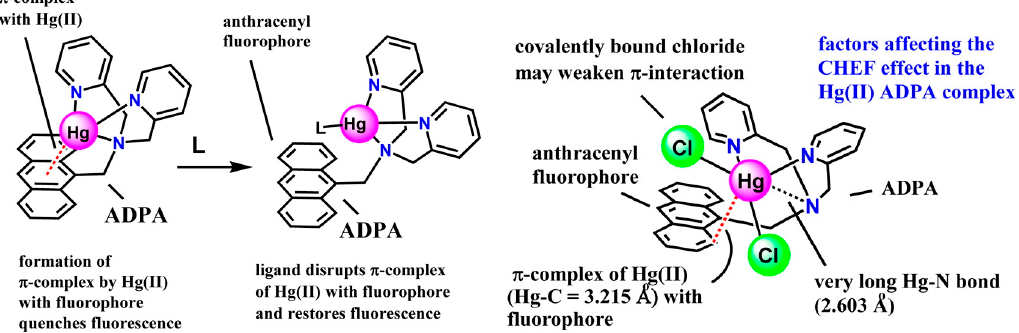
Figure 10. Effect of co-valent donor species on the fluorescence Hg 2+ / N- (9-anthracenylmethyl)- N -(2-pyridylmethyl)-2-pyridinemethanamine (ADPA) complex. Reprinted with permission from Reference [60]. Copyright (2012) American Chemical Society.